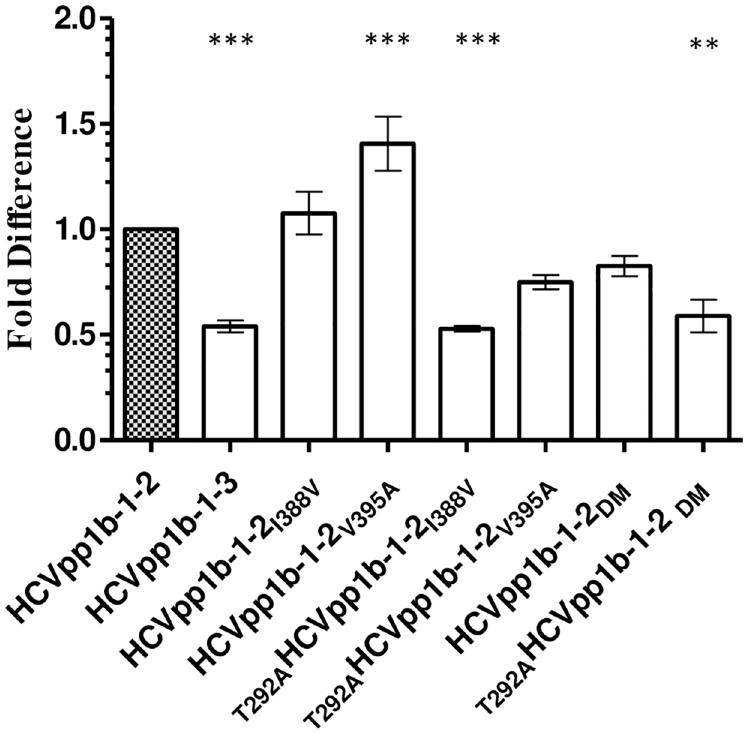
Fig 2. Mutation in the E1 glycoprotein affectsthe infectivityof HCVpp. Six mutant clonesweregenerated for highlyinfectiousHCVpp1b-1-2 as follows,1b-1-2 I388V, 1b-1-2 V395A , T292A 1b-1-2 I388V, T292A 1b-1-2 V395A, 1b-1- 2 DM and T292A 1b-1-2 DM (DM corresponds to doublemutant I 388 V andV 395 A). Wild type clonesHCVpp1b-1-2 andHCVpp1b-1-3wereusedas controls.As a referenceinfectivityvalueof HCVpp1b-1-2was set to 1. Mutation in the E1 glycoprotein reducesthe infectivityof HCVpp1b-1-2. Pairwisemutationat position292and388